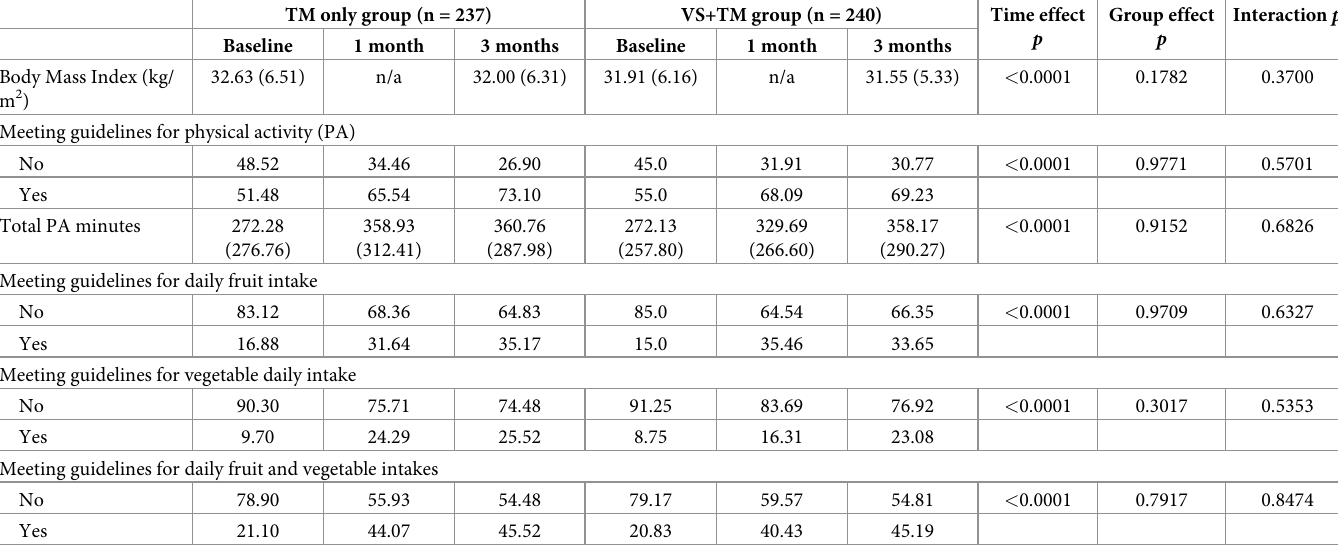
Table 3. Effects of intervention on Body Mass Index, physical activity and fruit and vegetable intakes, by group (n = 477). TM only group (n = 237) VS+TM group (n = 240) Time